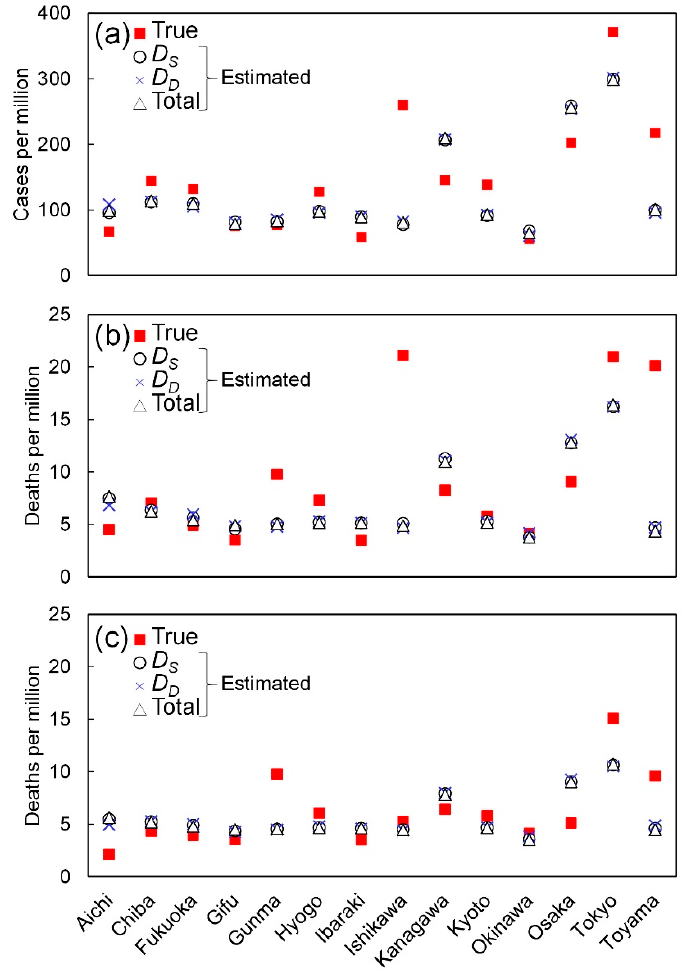
Figure 5. Multivariate linear regression with population density, elderly percentage, daily maximum absolute humidity averaged over spread duration. The number of ( a ) positive cases, and confirmed deaths ( b ) including and ( c ) excluding those caused by nosocomial infection. Table 6. Coefficients of determination and adjusted R 2 values for multivariate linear regression. Cases Deaths Deaths (Ex.)